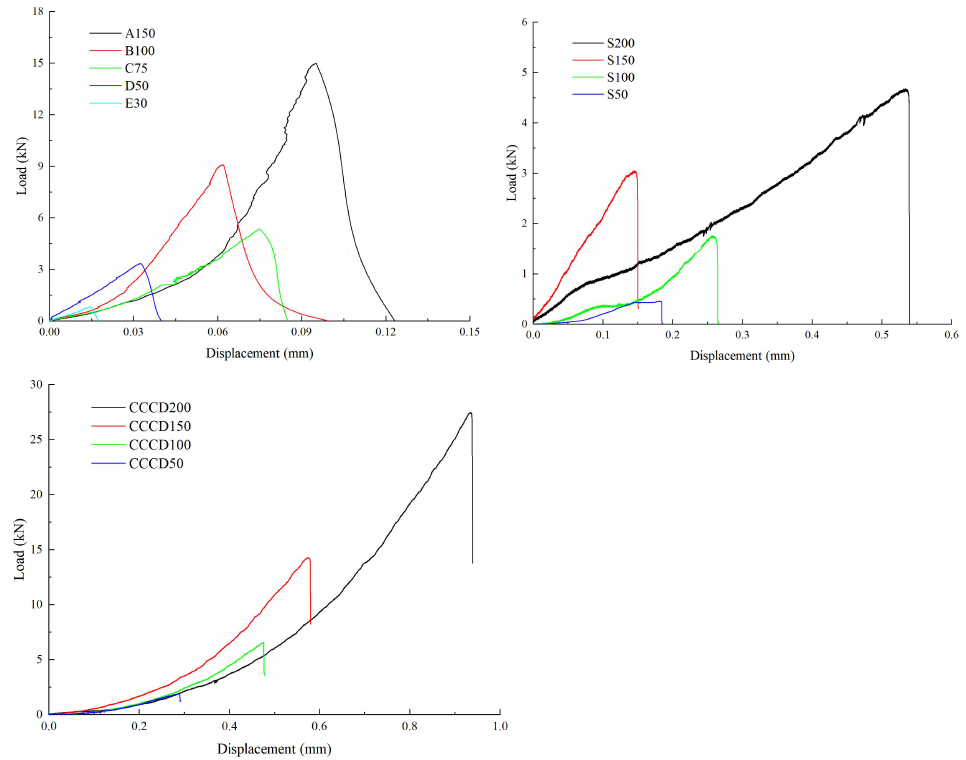
Figure 2. Load–displacement curve (the letters represent the group and the following number is the diameter of the specimen).